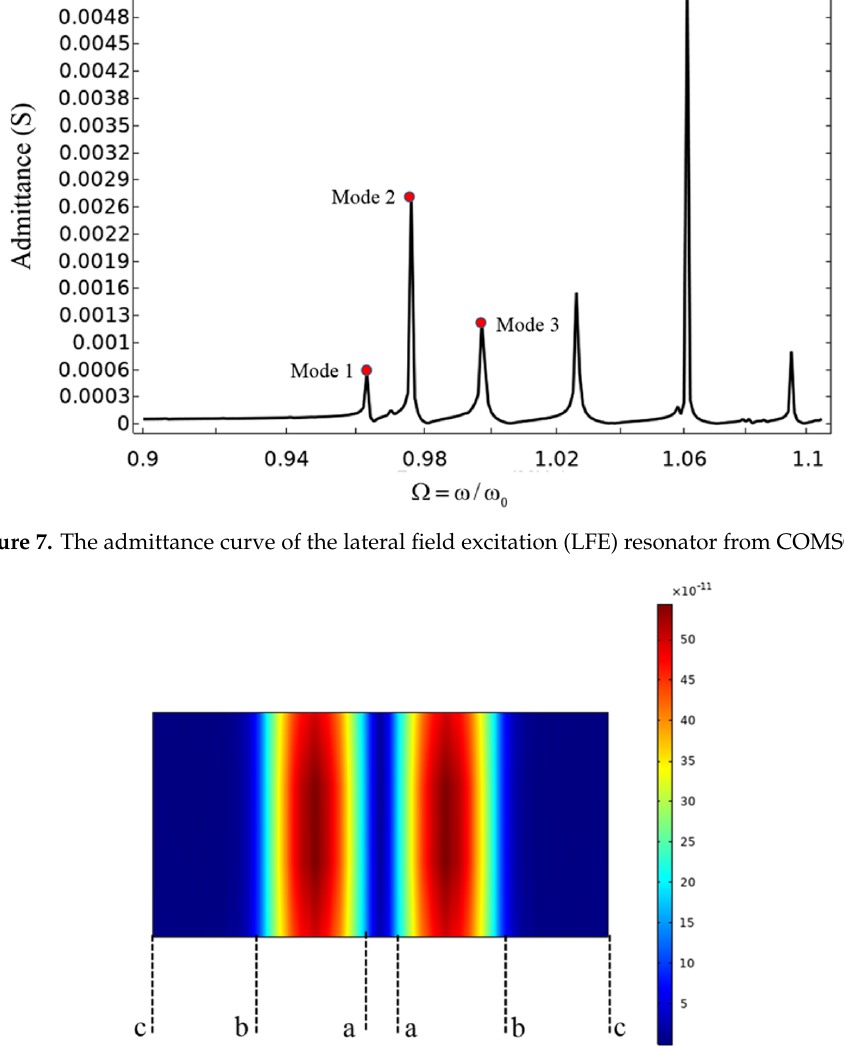
Figure 9. Resonance frequencies of resonators for varied parameters: ( a ) electrode/plate mass ratio R ; ( b ) electrode gap a ; ( c ) electrode width b.